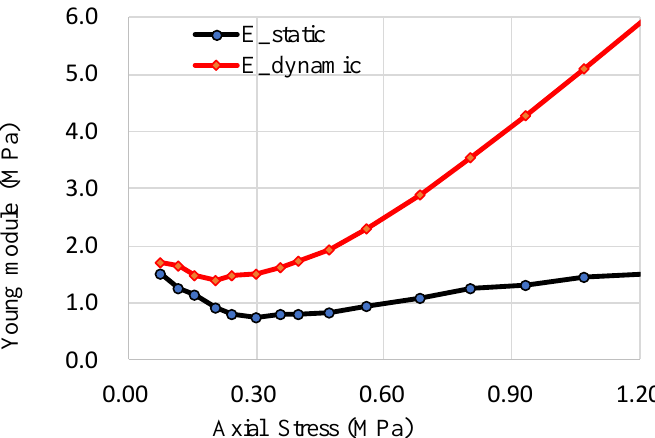
Figure 6. The equivalent static Young’s modulus and dynamic Young’s modulus of a silicone rubber strip under different stress states.